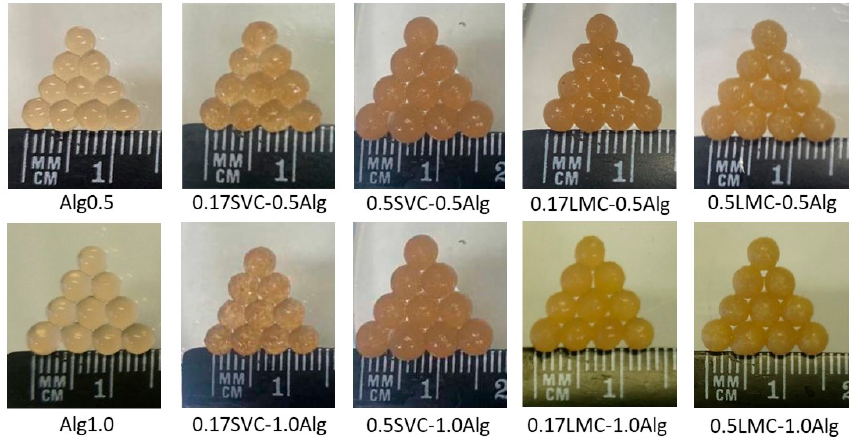
Figure 1. Digital images of GSE-loaded Ca-alginate particles and hydrogel particles based on alginate and cells of campion (SVC) and duckweed (LMC) callus cultures.